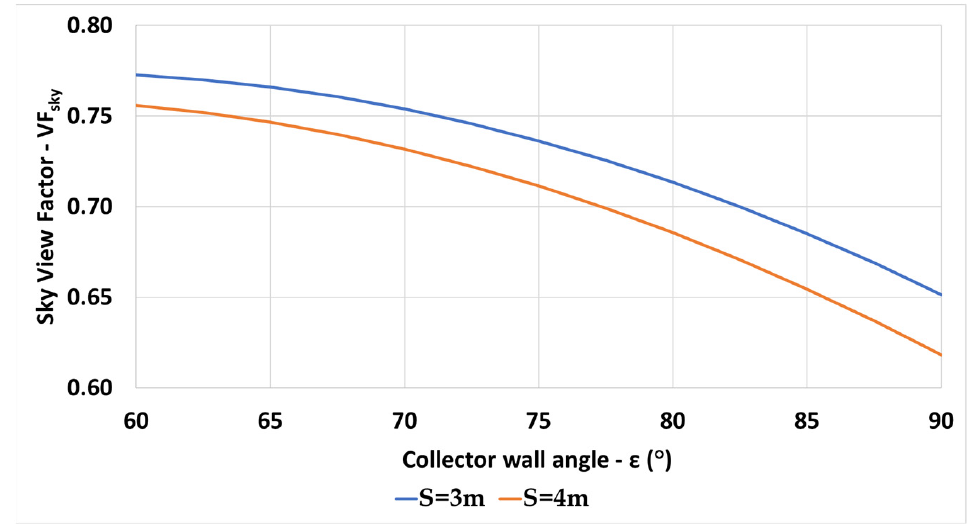
Figure 21. Variation of the sky view factor of collector with wall angle, ε —top collector. The variation of the sky view factor of a bottom collector, H = 2 m, with the collector angle, ε , from the wall (see Figure 10) is shown in Figure 22. Larger distances ( D ) between the top and the bottom collectors increase the sky view factor.